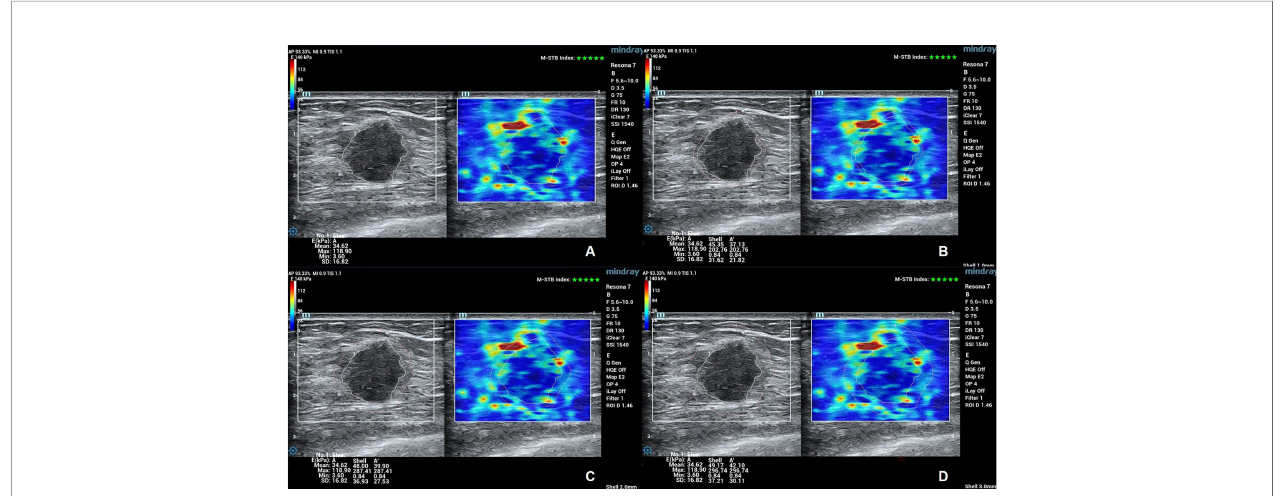
FIGURE 1 | B-mode and SWE images of a patient with invasive breast tumor. The “ stiff rim ” sign presents on the SWE images. (A) SWE images and parameters of outlined tumor. The E max , E mean , E min , and E sd of internal tumor were 34.63, 118.90, 3.60, and 16.82 kPa. (B) SWE images and parameters of shell 1 mm. The E max , E mean , E min , and E sd of shell 1 mm were 45.35, 202.76, 0.84, and 31.62 kPa. (C) SWE images and parameters of shell 2 mm. The E max , E mean , E min , and E sd of shell 2 mm were 48.00, 287.41, 0.84, and 36.93 kPa. (D) SWE images and parameters of shell 3 mm. The E max , E mean , E min , and E sd of shell 3 mm were 49.17, 296.74, 0.84, and 37.21